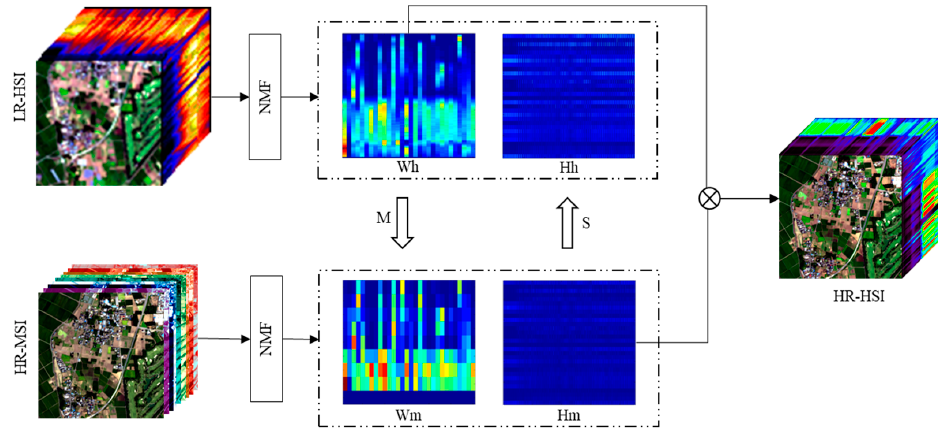
Figure 2. Illustration of endmember matrix constraint unmixing.